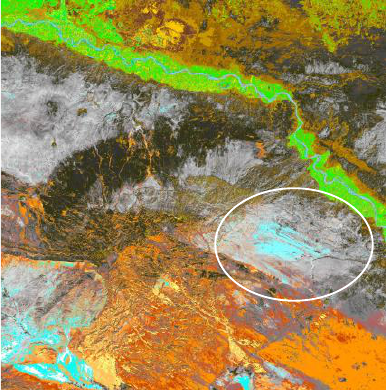
Figure 6. The cluster analysis of the vegetation cover of Jebel Bishri carried out by using Landsat-7 ETM image. The palaeolake area is encircled in white. Analysis by M. Törmä